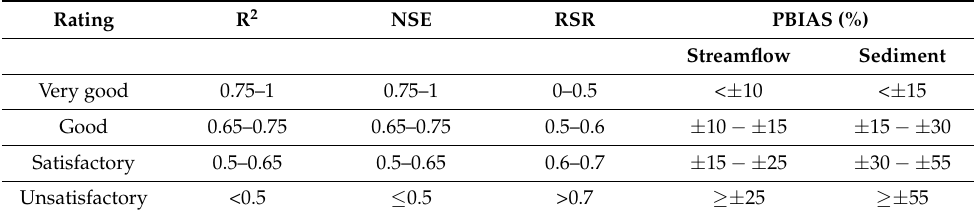
Table 3. Model’s performance and allowable range for both calibration and validation